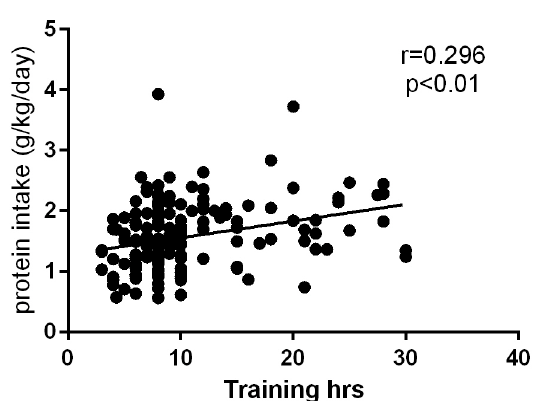
Figure 3. Relationship between total protein intake (including supplements) and weekly training hours. Correlation revealed a significant positive relationship between the two variables ( p < 0.01).